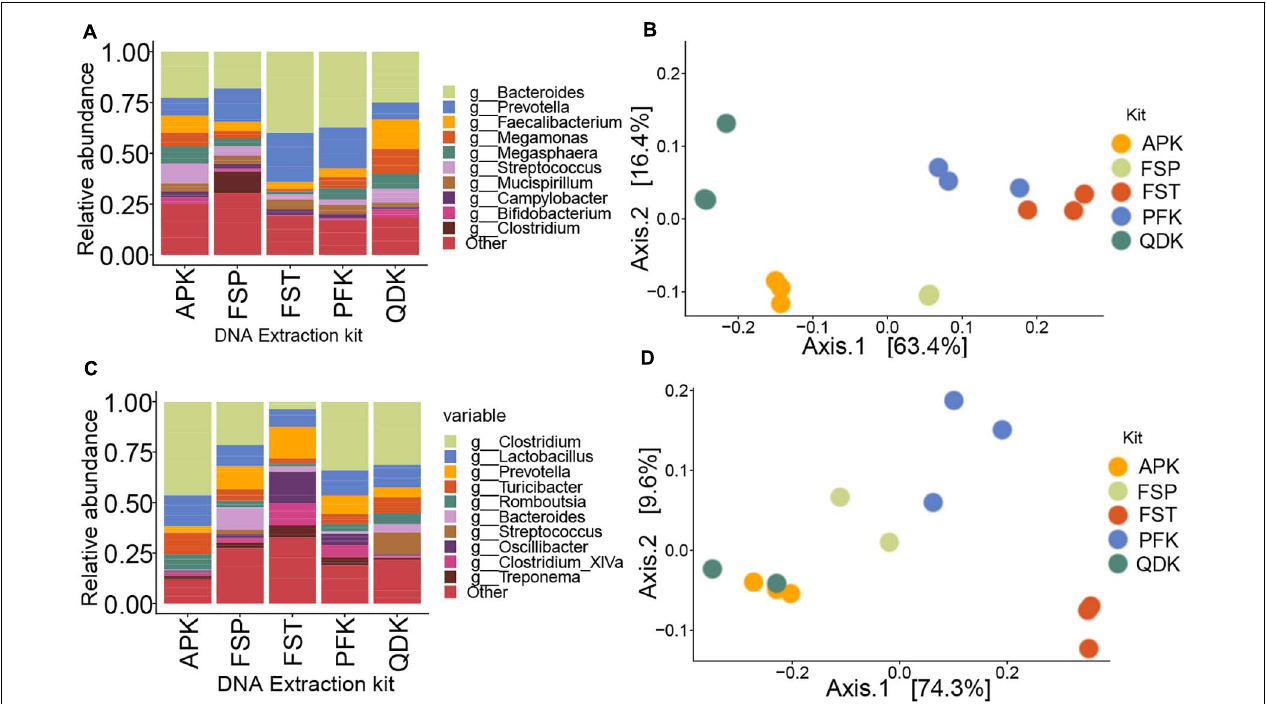
FIGURE 5 | Performance comparisons among DNA isolation kits in 16S rRNA gene sequencing of livestock samples. Within the relative abundance analysis, the top 10 genera are shown for comparison of pooled samples from chicken cecum (A) and pig feces (C) . Species that were not present in more than 10% of the samples were removed. Principal coordinate analysis (PCoA) plot based on Bray–Curtis dissimilarity was used to examine the dissimilarities between microbial communities in the chicken- (B) and pig- (D) derived